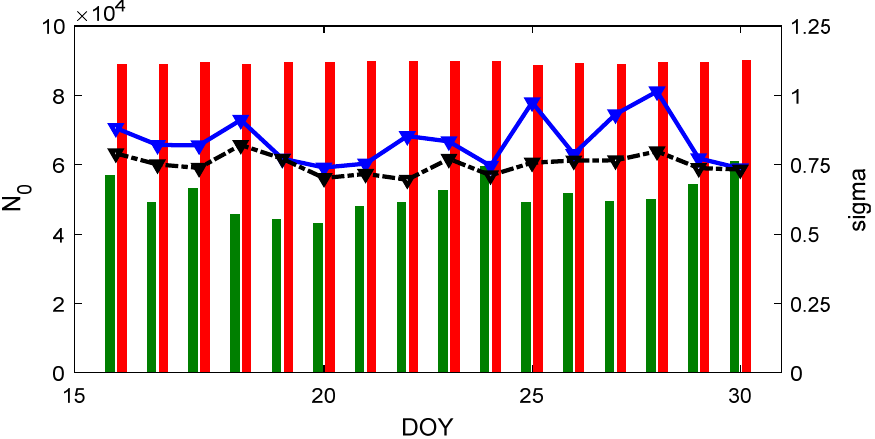
Figure 7. The left axis represents the total numbers of DCB combinations N 0 (bar plot) in case 1 (red) and case 2 (green) and the right axis represents the weighted residuals (line plot) in Equation (17) in case 1 (blue) and case 2 (black). The horizontal axis represents the day of year in 2011.